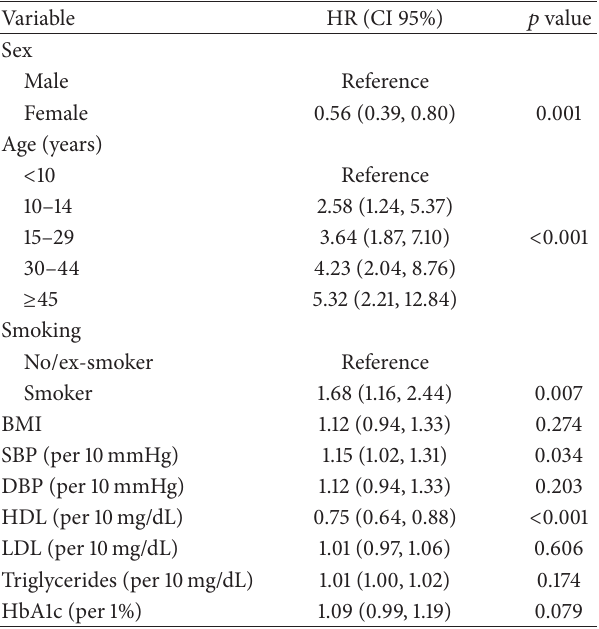
Table 5: Multivariate analysis to analyze the association of the development of DR with age at T1D onset and with DBP, HDL, and HbA1c along the